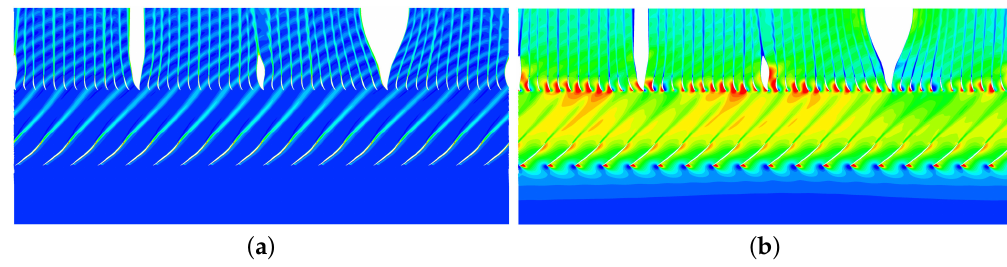
Figure 9. Entropy ( a ) and Mach number ( b ) contours at mid-span for the axisymmetric air-inlet